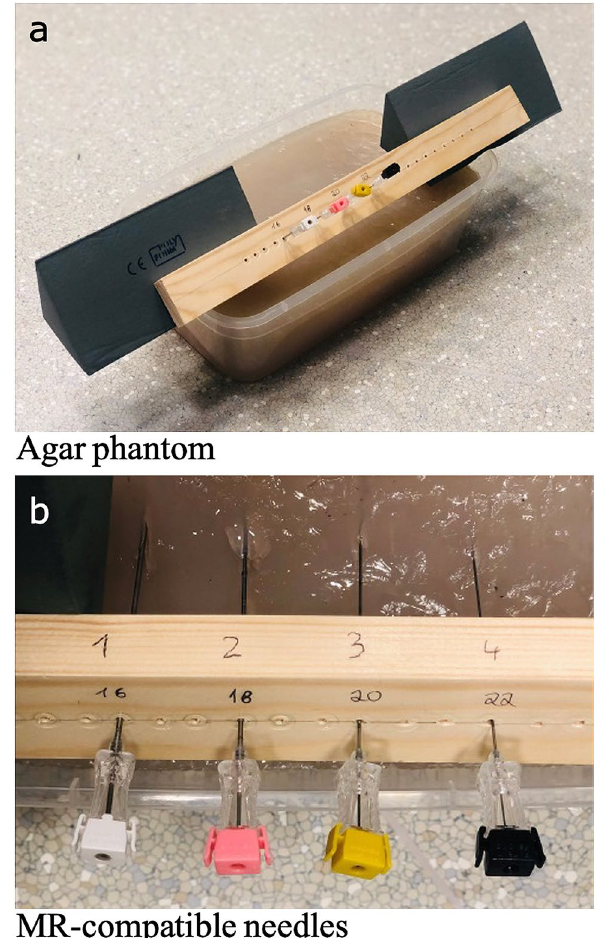
Figure 6. Experimental setup. Agar phantom with needle holder device ( a ): The phantom was composed of water, agar–agar, and sodium chloride and cured in a polyvinyl chloride container. Coaxial MR-compatible needles with different diameters ( b ) were introduced in a needle holder device firmly attached to the polyvinyl chloride container at a 45° angle. To evaluate the individual intervention angles to the B 0 field, the phantom was tilted towards the B 0 field for the intervention angles 30°, 15° and 0° and in the opposite direction for the angles 60°, 75° and